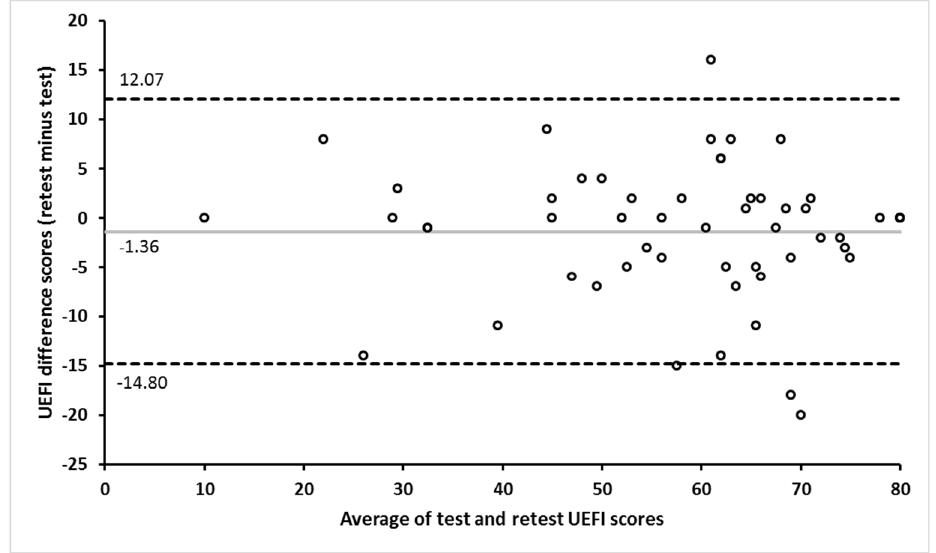
Figure 2. Bland–Altman plot showing the agreement between the UEFI test and retest scores. The gray horizontal line represents the mean difference between the test and retest scores. The upper and lower dashed horizontal lines represent the 95% limits of agreement.